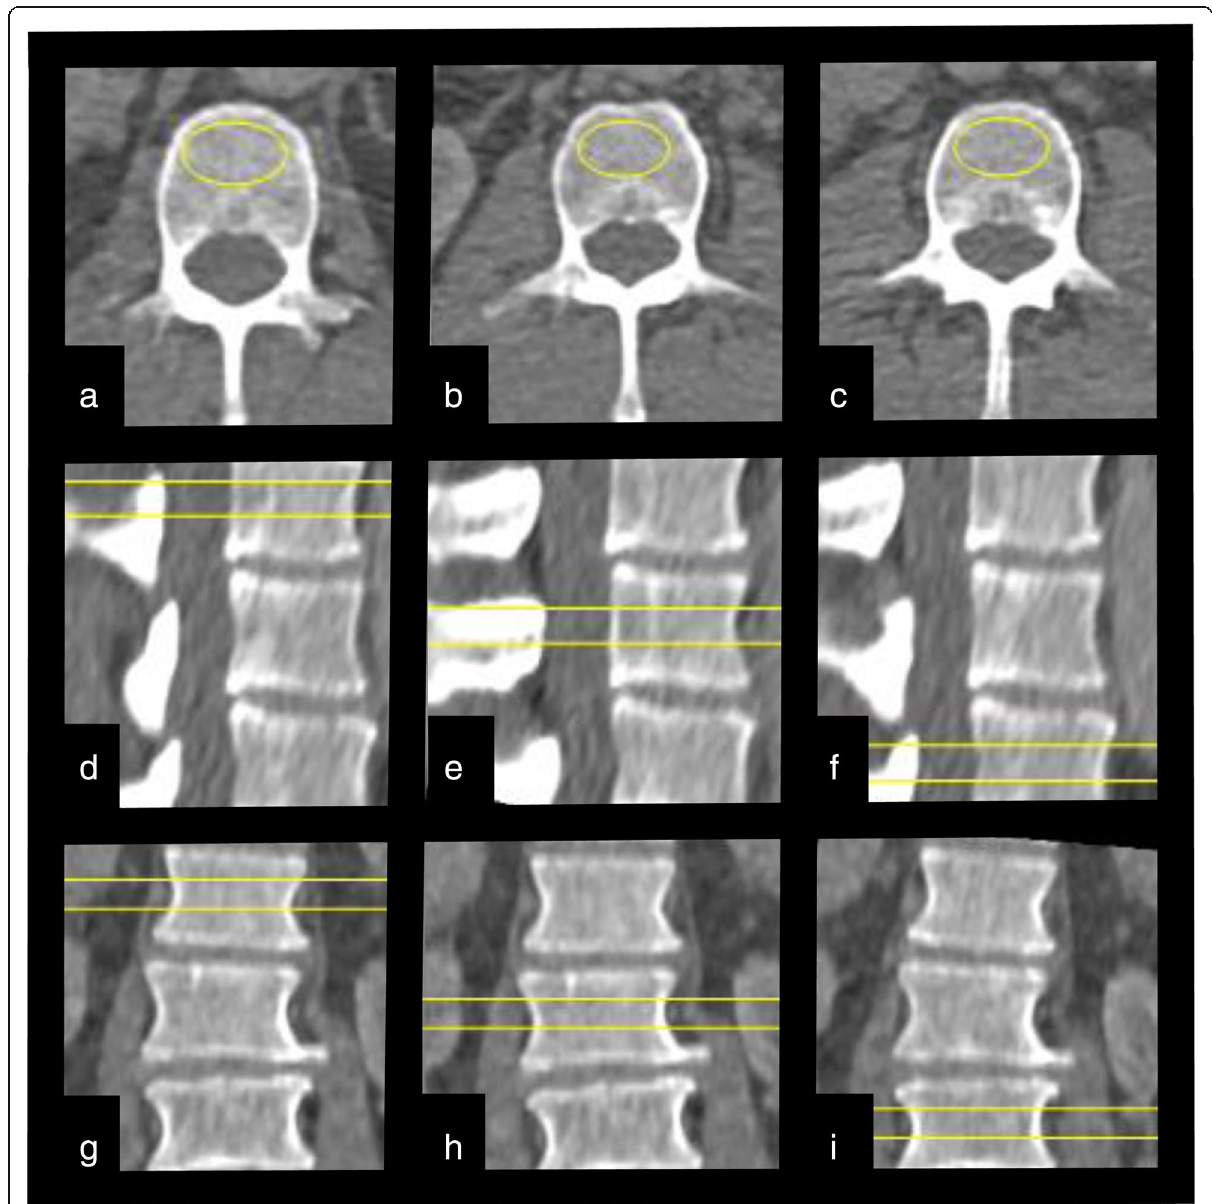
Fig. 2 Images of the region of interest (ROI) placement in the Mindways software where panels a , d , and g represent vertebra L1 in the axial, sagital and coronal plane, respectively. Panels b , e , and h represent L2 in the 3 different planes while panels c , f , and i represent L3. The ROIs were made as large as possible, including as much trabecular bone material as possible, but carefully avoiding vessels, cortical, sclerotic, and cystic